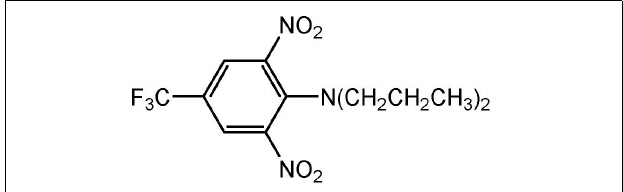
FIGURE 1 | Trifluralin chemical